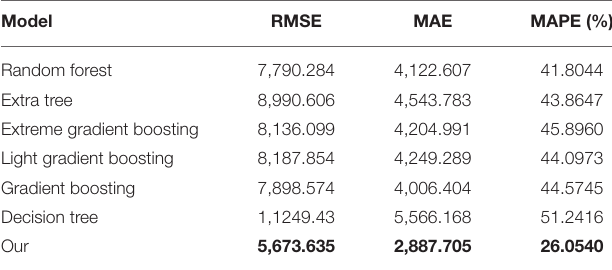
TABLE 2 | The values of RMSE, MAE, and MAPE results for different methods.